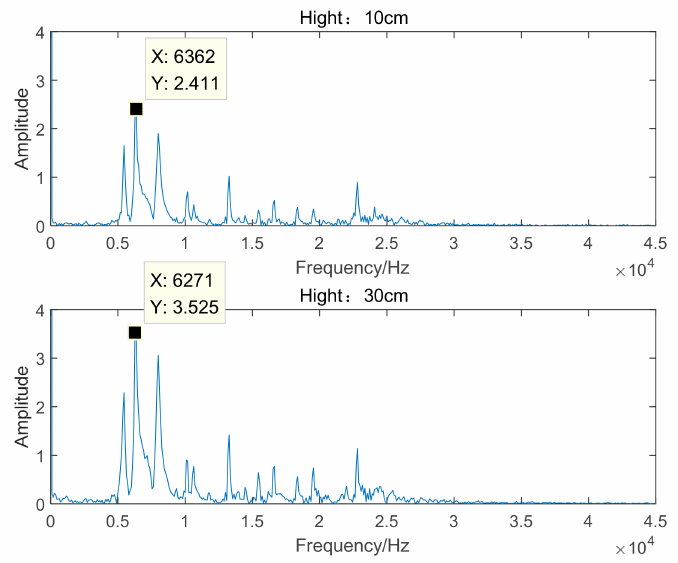
Figure 8. 10 cm and 30 cm amplitude-frequency characteristic curves.